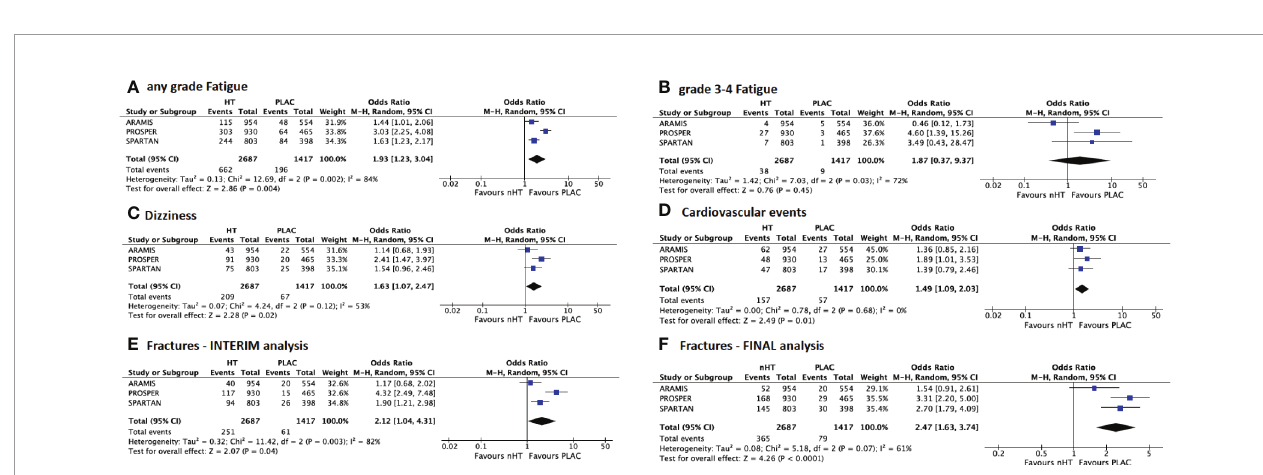
FIGURE 3 | Forest plots reporting pooled safety outcomes from interim analyses of the 3 included studies. (A) any grade and (B) grade 3 – 4 fatigue; (C) dizziness; (D) cardiovascular events; (E) fractures from interim analysis; (F) fractures from fi nal analysis. [CI, con fi dence interval; nHT, novel hormonal therapy; PLAC,